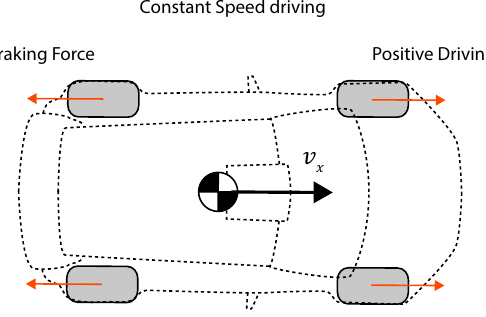
Figure 13. Active force excitation strategy proposed by Albinsson et al.